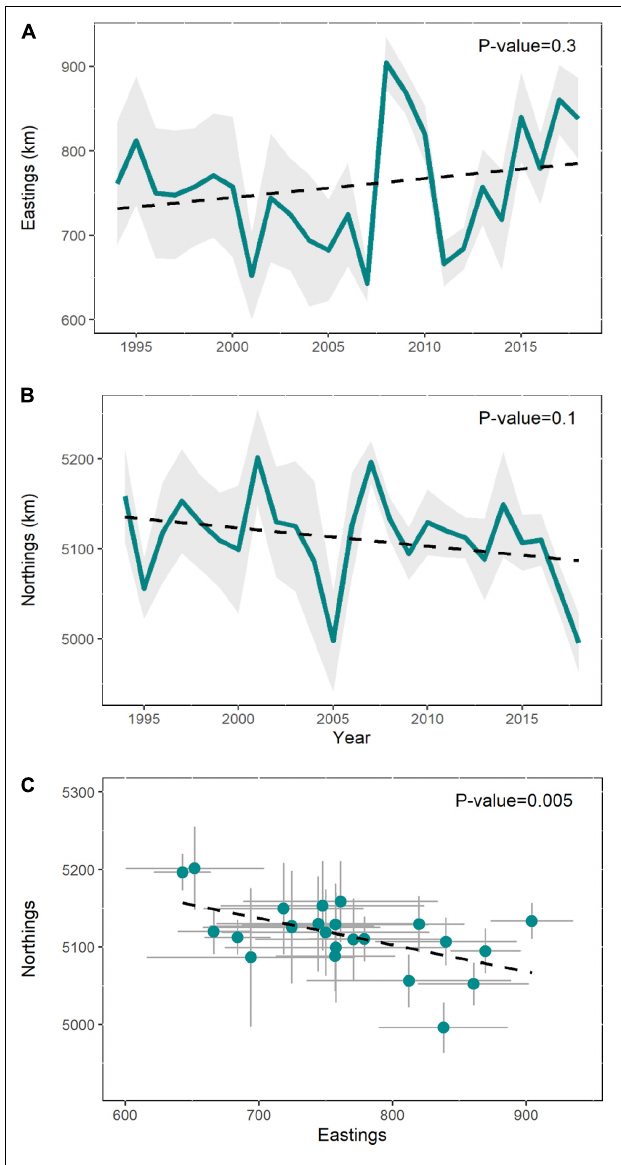
FIGURE 5 | The variation in the center of gravity (CoG) of common dolphin expressed in eastings (A) and northings axes (B) , and as a function of both (C) . Shaded area means the standard error, while the dashed line indicates the linear